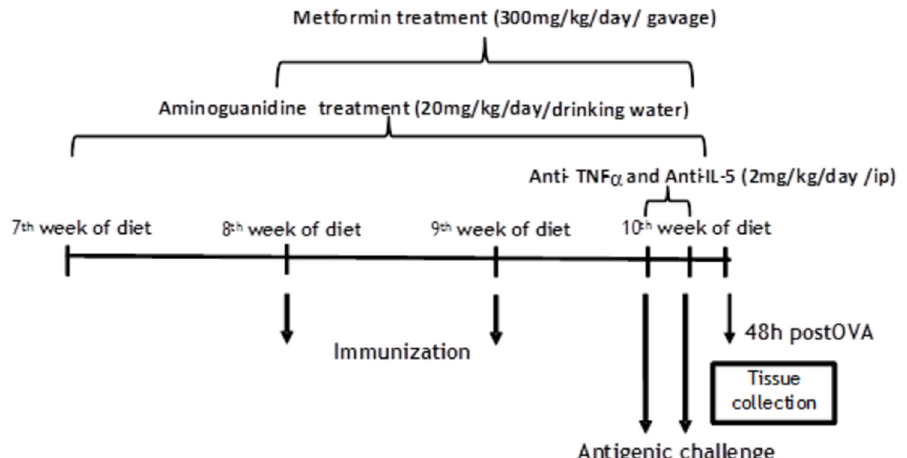
Figure 2. Schematic representation for treatments with metformin, aminoguanidine, anti-TNF-α and anti-IL-5 in ovalbumin (OVA)-sensitized and challenged